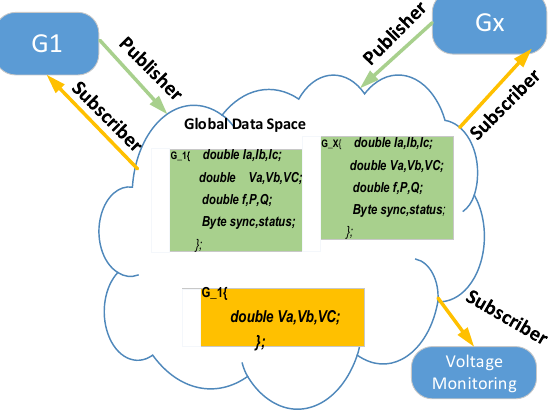
Figure 3. Generators data structure and pub/sub example. Table 1. Objects and topics list. Photovoltaic: PV.